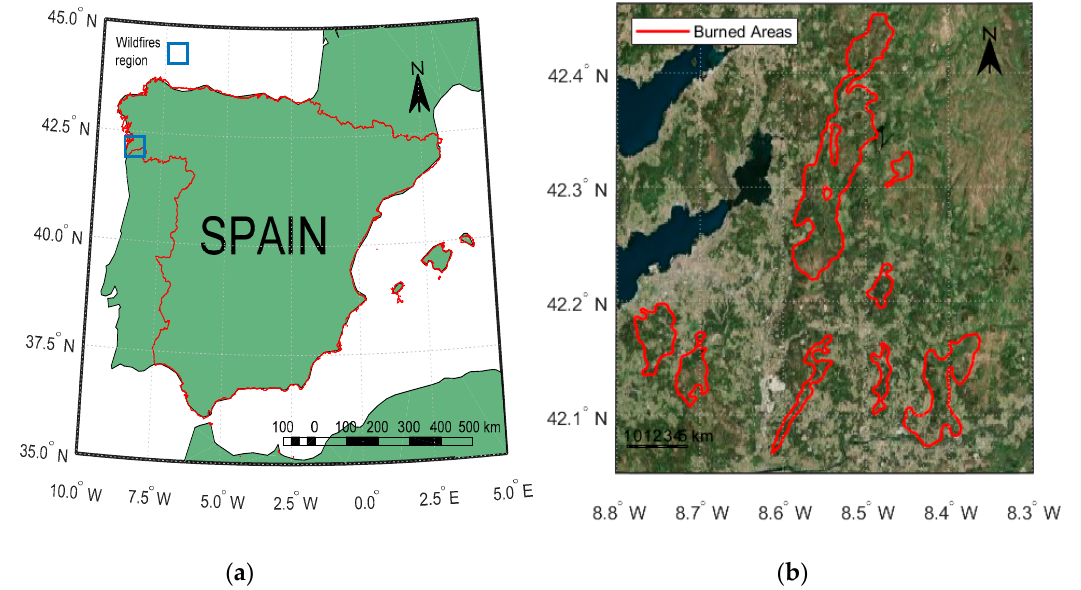
Figure 1. ( a ) Wildfires study region (color blue) located in Pontevedra (Galicia) in northwestern Spain; ( b ) zoom of wildfires region with burned areas perimeters (red color). The reference coordinate system is WGS84 (EPSG: 4326).